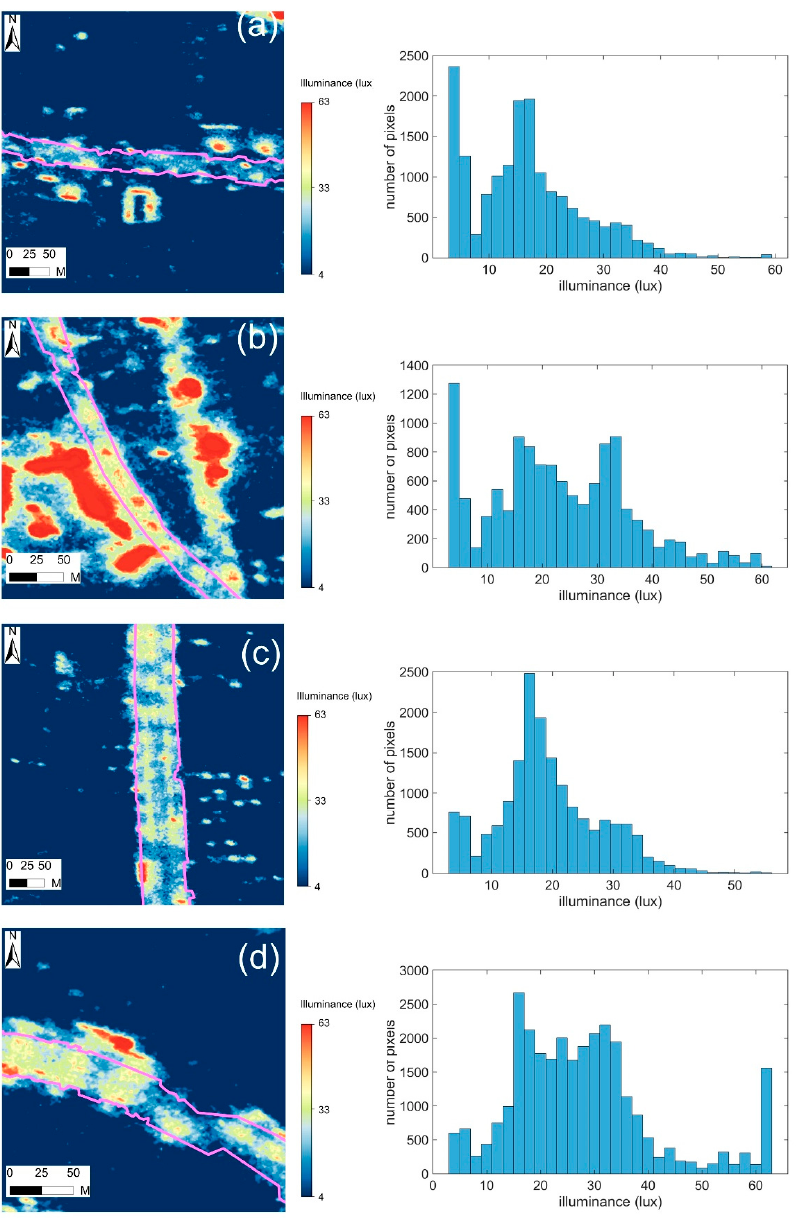
Figure 10. The illuminance maps and histograms of 4 typical roads. The purple box shows the roads’ scopes: ( a ) Jianning Road; ( b ) Hubei Road; ( c ) Hongshan Road; and ( d ) Longpan Road. To illustrate the illuminance more clearly, illuminance maps show local sections of the road. Histograms represent the illuminance of the whole road.